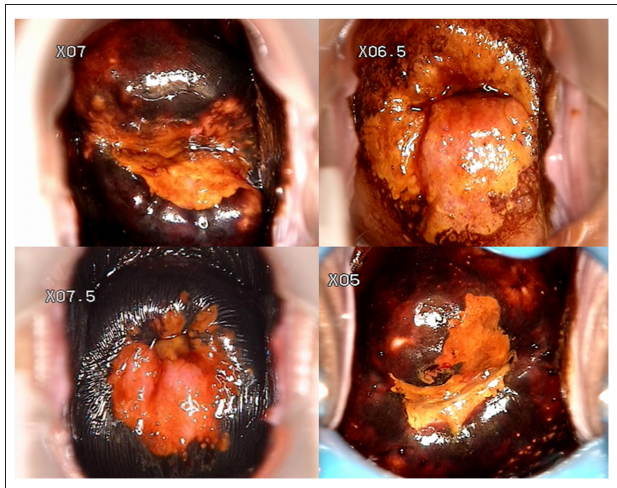
FIGURE 2 | Preoperative colposcopic images of 4 patients with positive